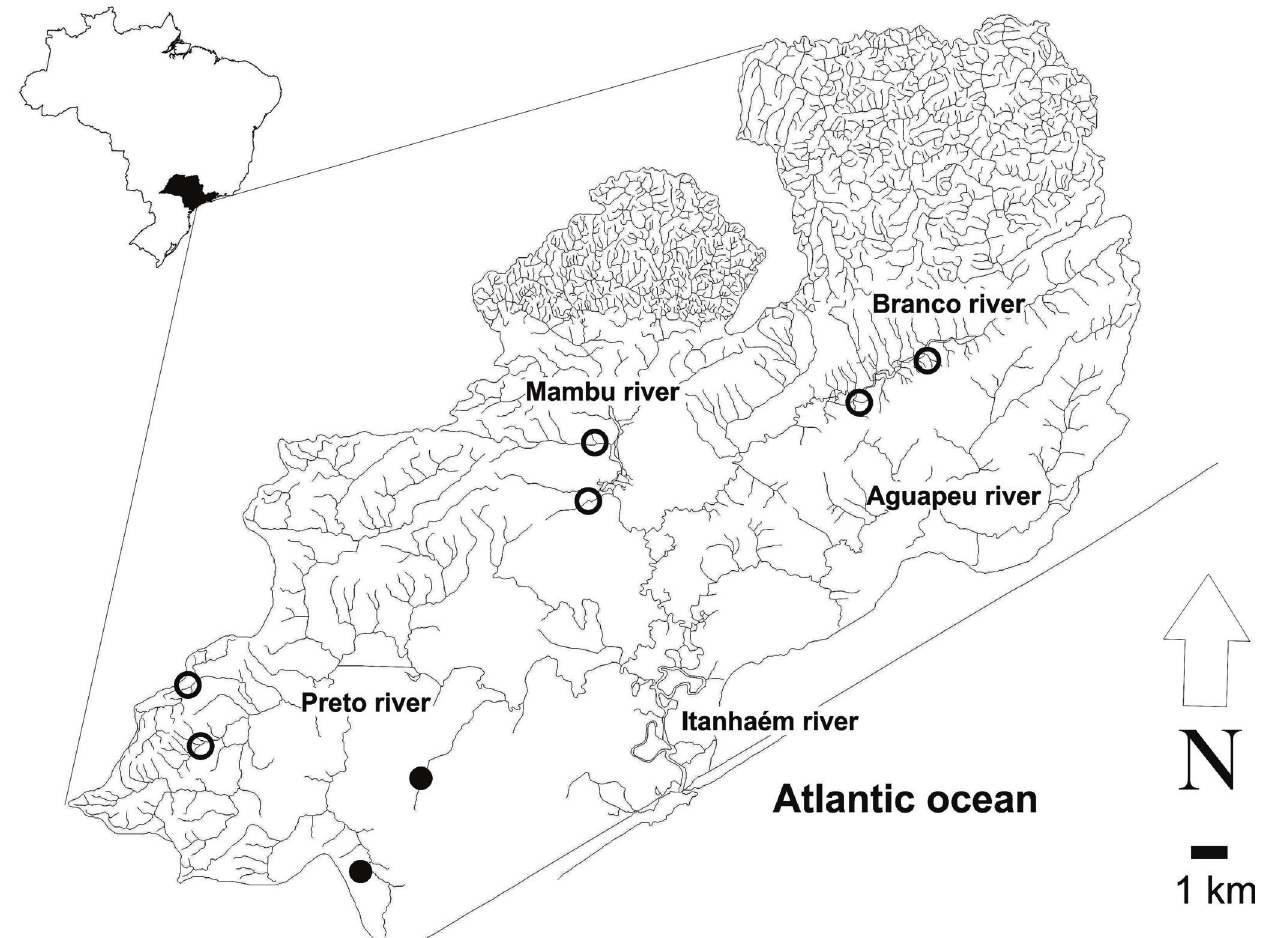
Fig. 1. Hydrography and location of the sampling sites (first to third-order streams) in the coastal plain of Itanhaém River basin, southeastern Brazil. Open circles: clearwater streams. Black circles: blackwater streams. Fish and habitat sampling Fishes were sampled in eight first to third-order